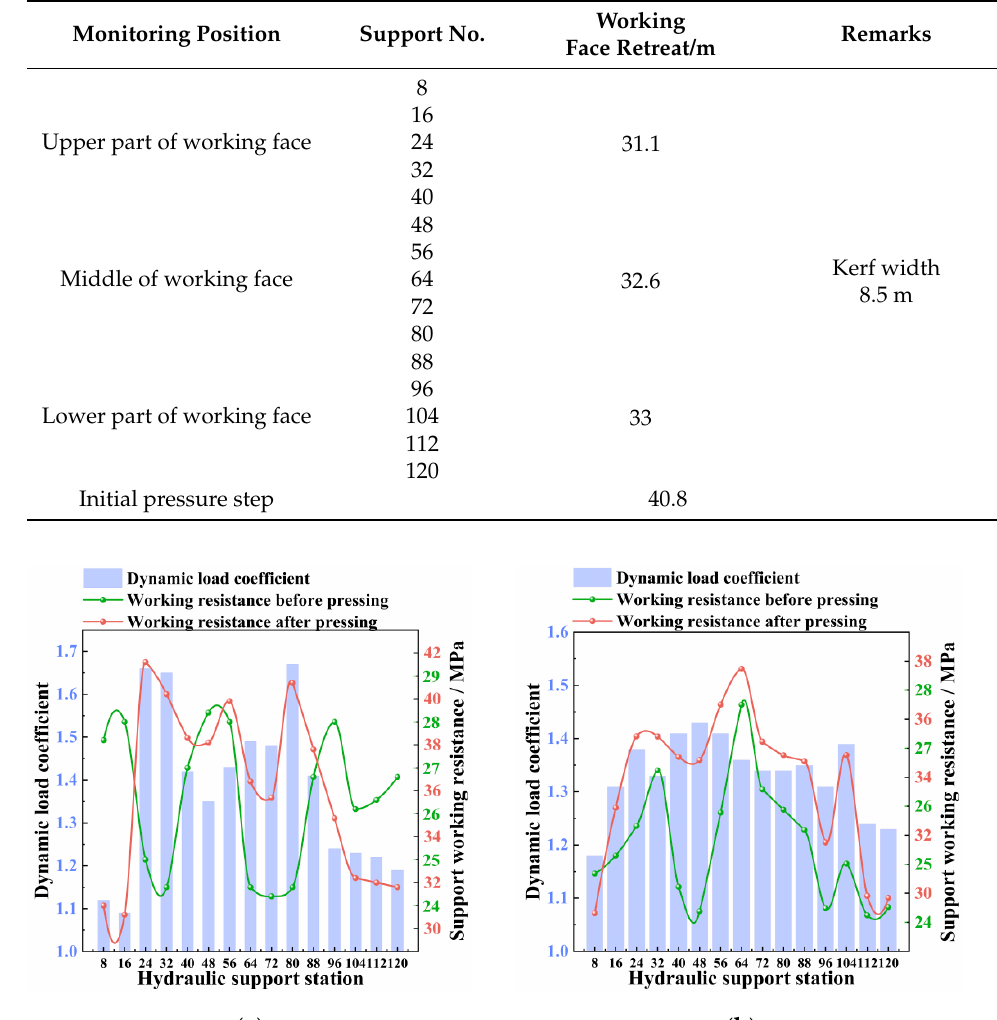
Table 4. Statistics of the initial incoming pressure step of the roof.